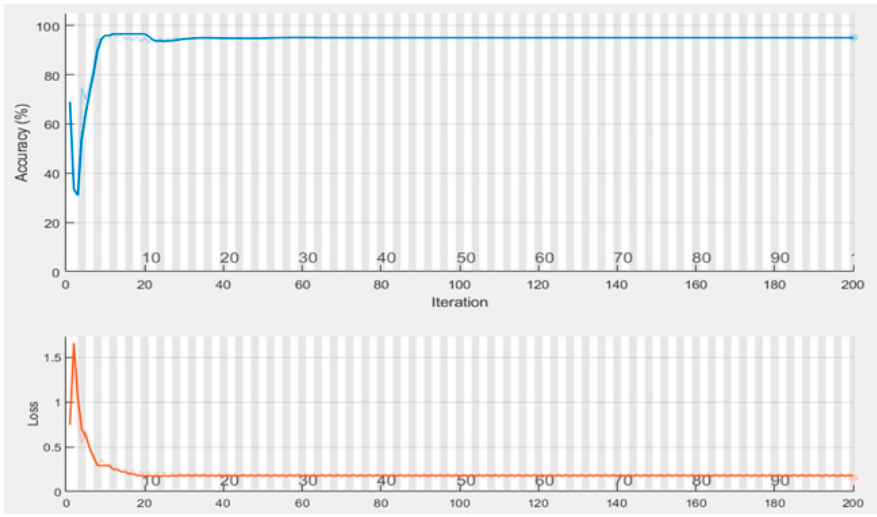
Figure 2. Training progress of the GRU-RNN for the WDBC dataset.